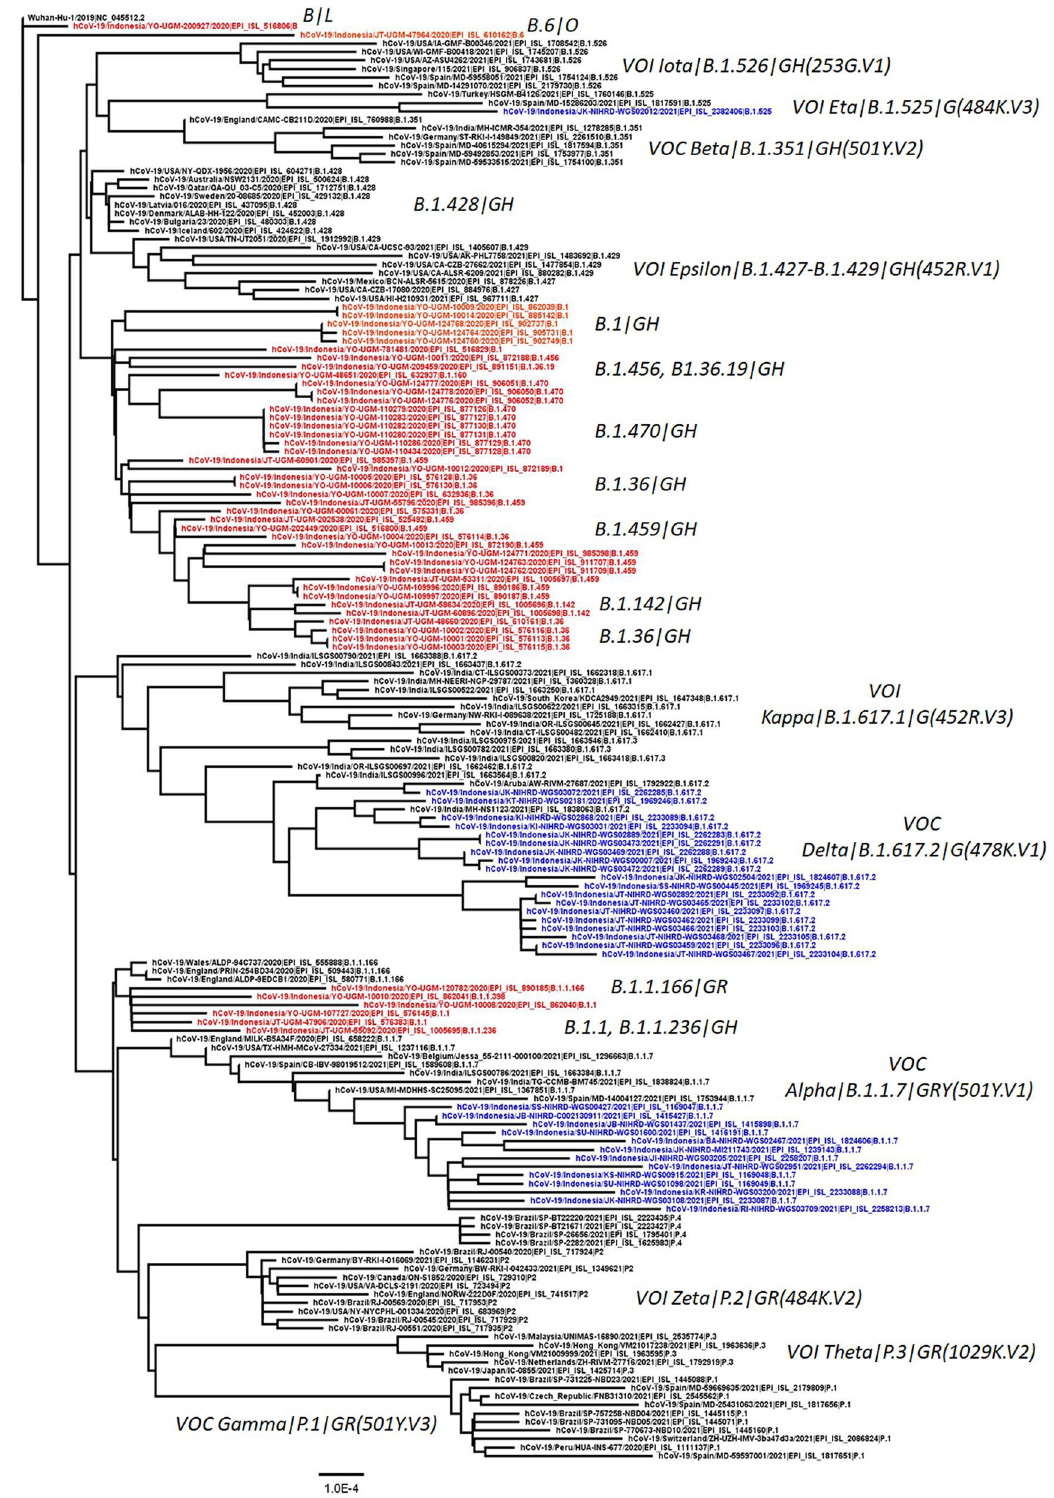
Figure 1. The evolutionary history was inferred using the Neighbor-Joining method 11 . The optimal tree is shown. The percentage of replicate trees in which associated taxa clustered together in the bootstrap test (1000 replicates) are shown next to the branches 12 . The tree is drawn to scale, with branch lengths in the same units as those of the evolutionary distances used to infer the phylogenetic tree. The evolutionary distances were computed using the Kimura 2-parameter method 13 and are in the units of the number of base substitutions per site. This analysis involved 170 nucleotide sequences. All ambiguous positions were removed for each sequence pair (pairwise deletion option). There was a total of 29,563 positions in the final dataset. Evolutionary analyses were conducted in